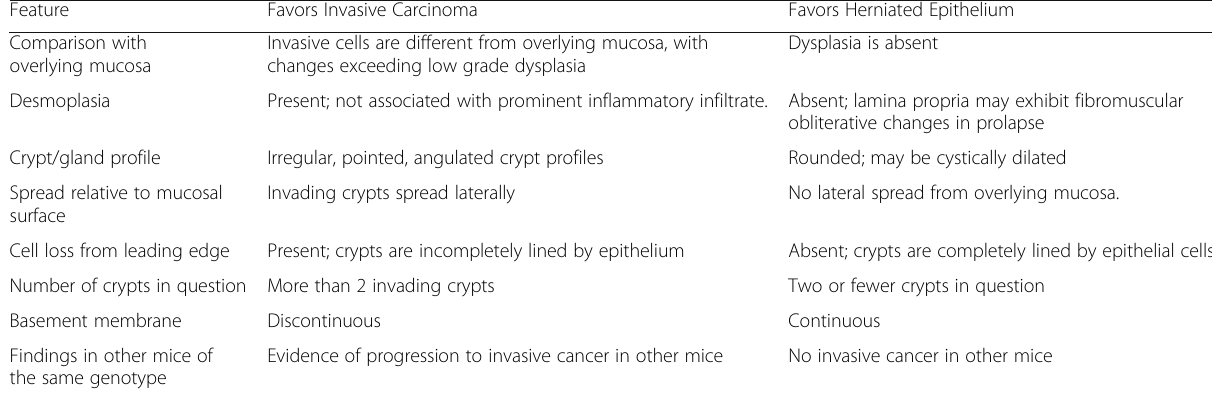
Table 4 Features helpful in distinguishing invasive adenocarcinoma from mucosal herniation (Boivin et al., 2003)